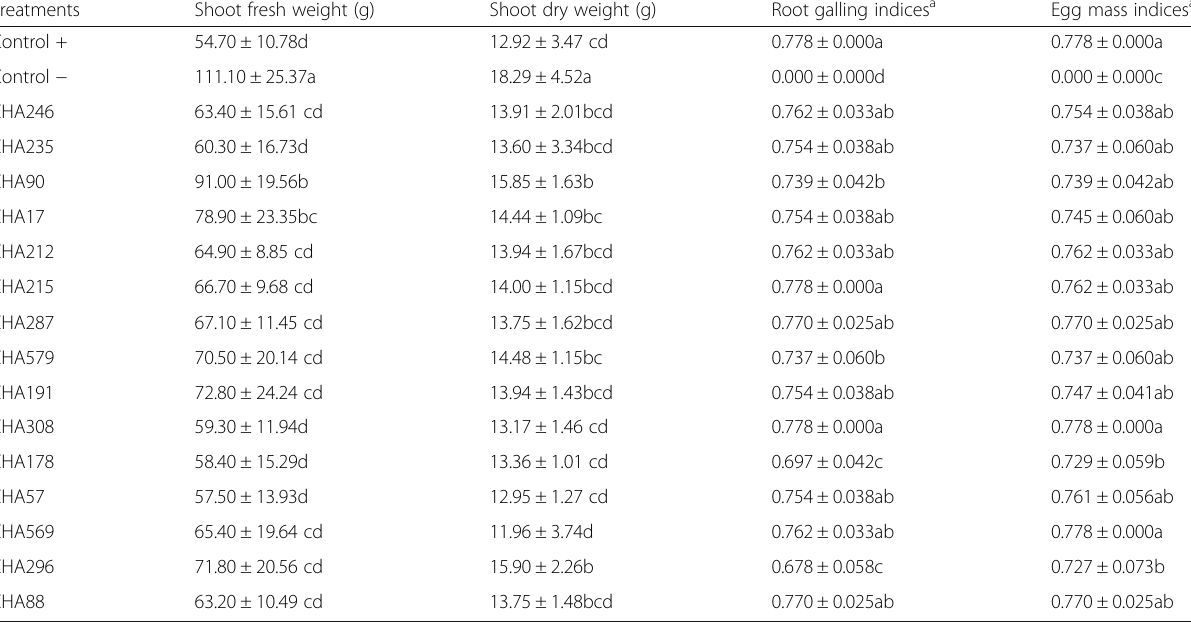
Table 3 Comparison of means of shoot fresh weight, shoot dry weight, root-galling indices and egg-mass indices of Meloidogyne incognita- inoculated tomato plants, following bacterial treatments (mean ± SD)